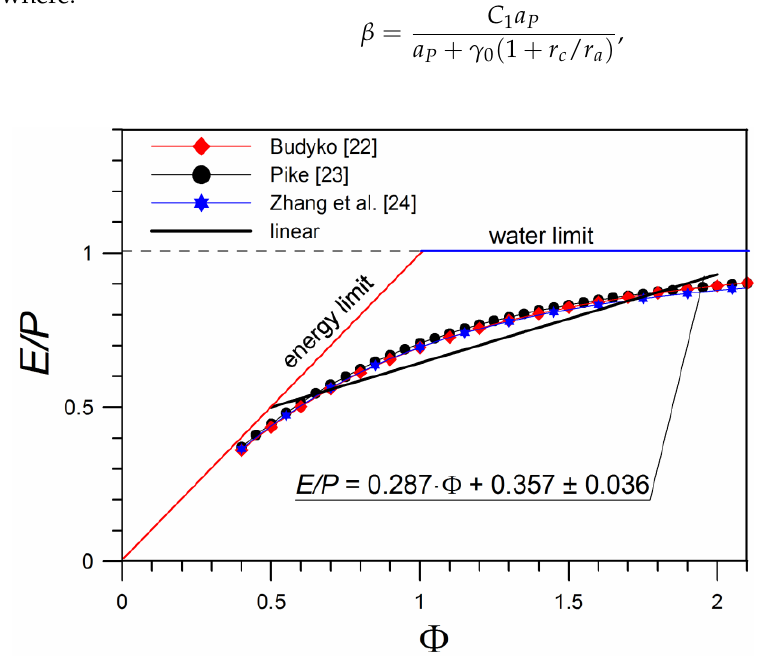
Figure 2. Linearization of the relationship between the E/P ratio and the aridity index Ф .